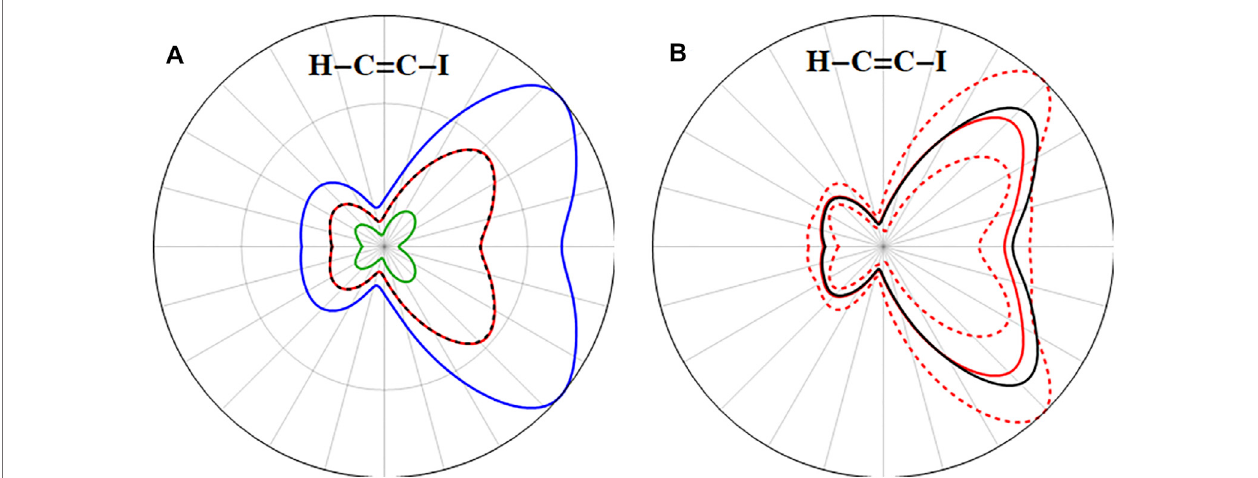
FIGURE 8 | (A) Comparison of the ionization yield (decrease in | Ψ | 2 ) for the X + A coherent superposition (red) with the incoherent superposition of X and A (black dashed);theionizationyieldsforX andAstatesindividuallyareingreenand blue,respectively. (B) Comparison oftheinstantaneousionizationratefortheX+Acoherent superposition (red) with the incoherent superposition of X and A (1:0.9 ratio, black) averaged over the last 2 fs of the simulation; maximum and minimum rates for X + A during the last 2 fs of the simulation shown as dashed red lines (same simulation parameters as in Figure 7